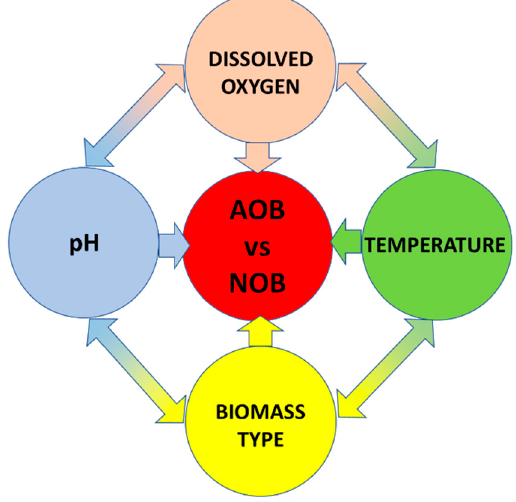
Figure 8. Interactions between different operational factors and ammonium oxidizing bacteria (AOB) ‐ nitrite oxidizing bacteria (NOB) competition. Table 5. The introduction of different biomasses retention strategies in literature.